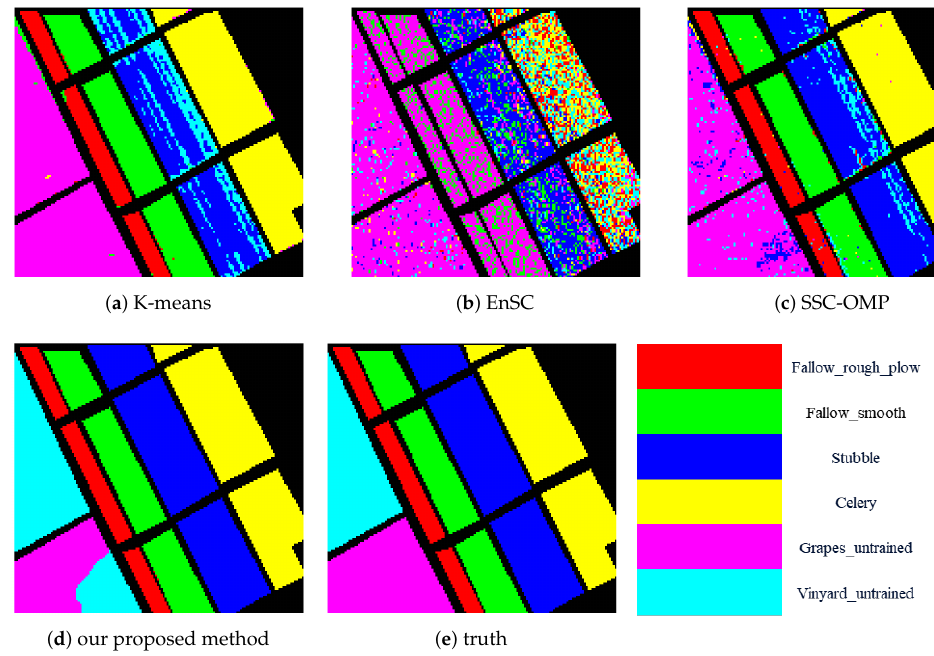
Figure 12. The clustering results of different methods on the Salinas